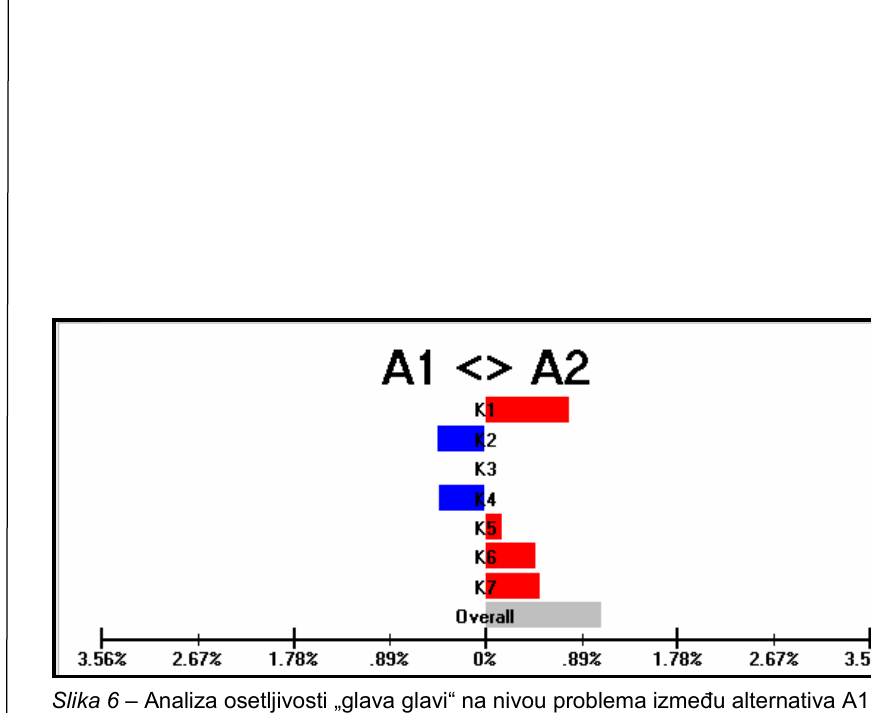
Figure 6 – Head to head sensitivity analysis at the level of the problem between A1 and A2 alternatives